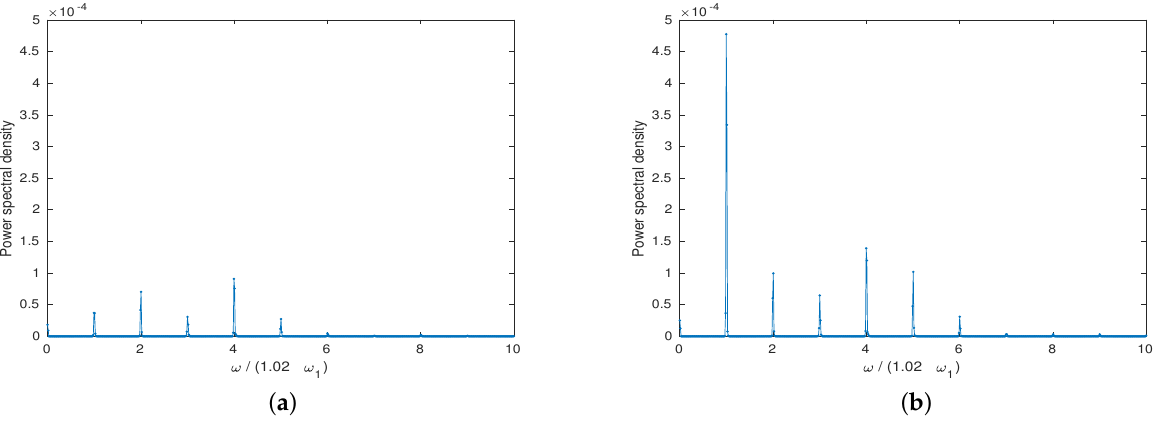
Figure 14. The frequency spectrum of coupled surge and sway cases under different excitation frequencies. excitation frequency : ω / ω 1 = 1.02, excitation amplitude : 0.001 m (surge); excitation frequency : ω / ω 1 = 1.02, excitation amplitude : 0.002 m (sway). ( a ) corner C. ( b ) corner